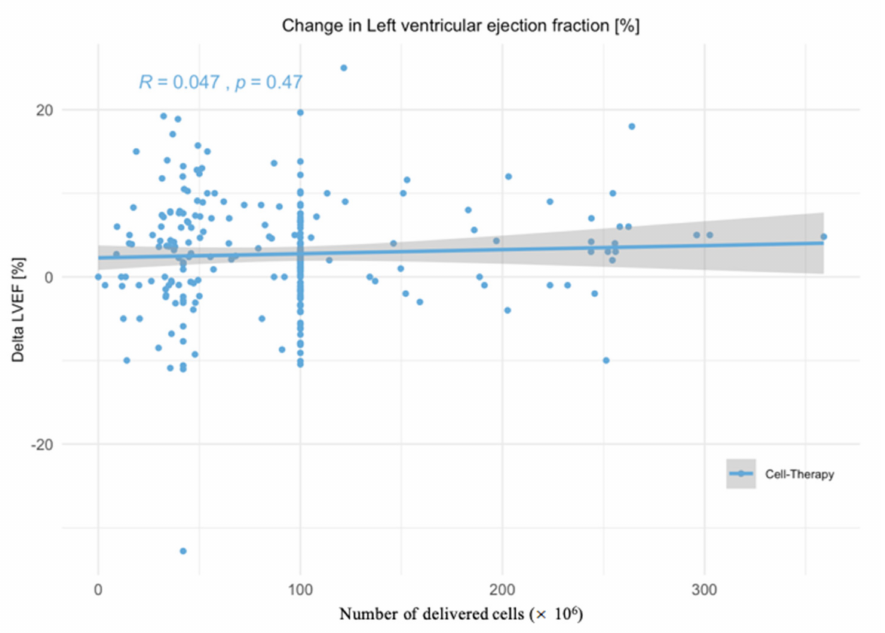
Figure 5. No correlation between number of injected cells and changes in left ventricular ejection fraction (LVEF) at follow-up only IPD of the ACCRUE studies included. Table 5. ( a ) Effect of cell therapy on changes in ejection fraction (EF) in percutaneous cell-therapy and control groups in ACCRUE patients with co-morbidities. ( b ) Effect of cell therapy on changes in end- diastolic volume (EDV) in percutaneous cell-therapy and control groups in ACCRUE patients with co-morbidities. ( c ) Effect of cell therapy on changes in end-systolic volume (ESV) in percutaneous cell-therapy and control groups in ACCRUE patients with